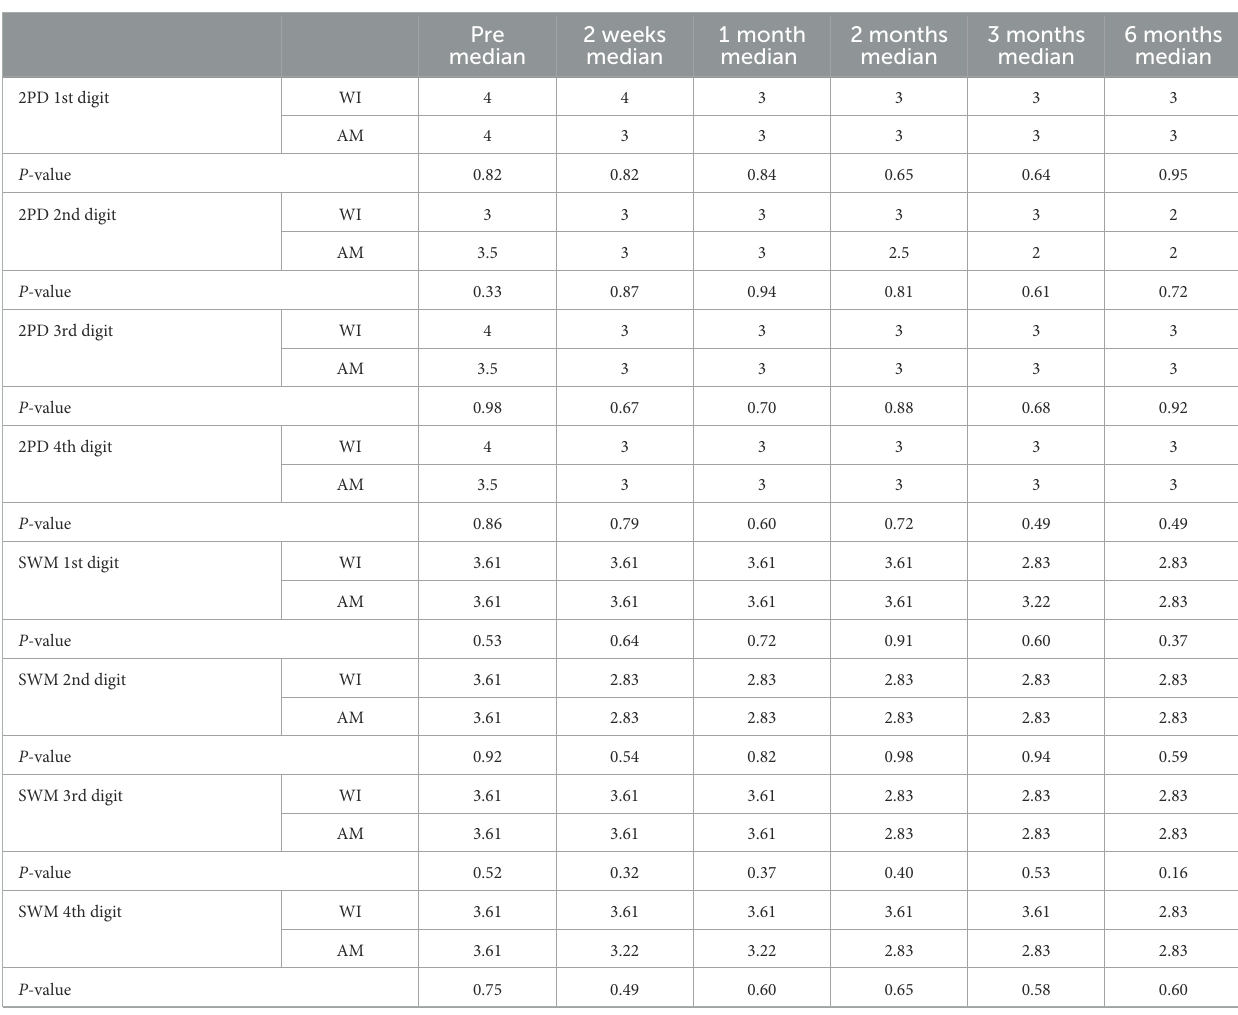
TABLE 3 Outcome measures of sensibility.